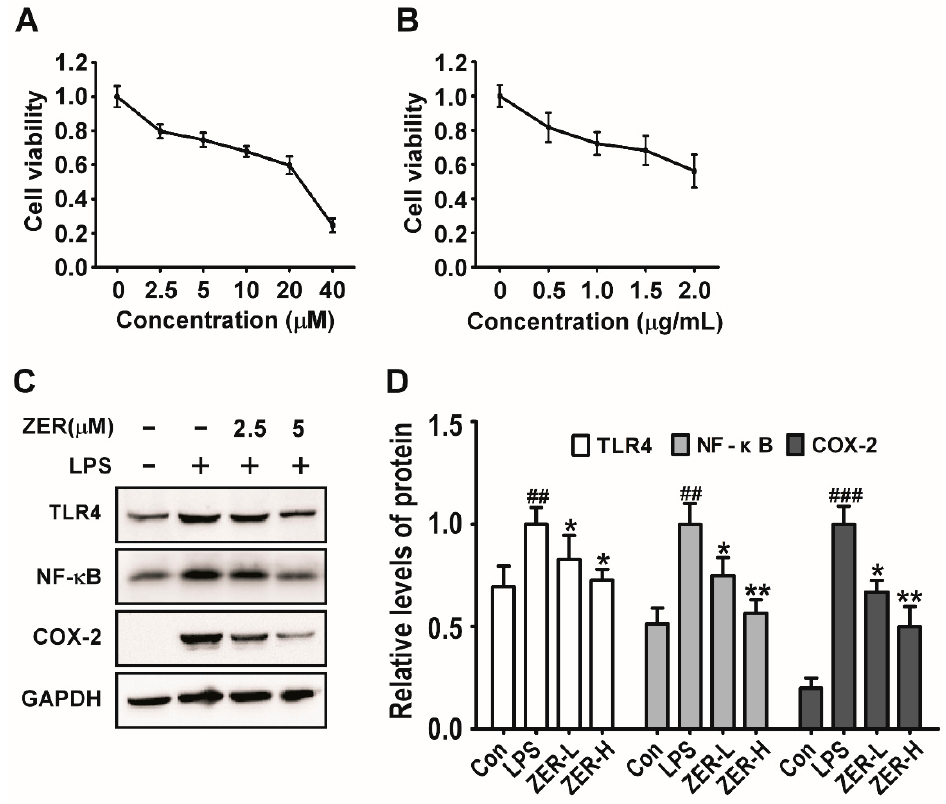
Figure 6. Effects of ZER on TLR4/NF- κ B/COX-2 signaling in LPS-induced Raw264.7 cells. ( A ) The cytotoxicity of ZER was evaluated by MTT assay. ( B ) The cytotoxicity of LPS was evaluated by MTT assay. ( C ) Western blotting analysis of TLR4, NF- κ B (p-p65), and COX-2; GAPDH was used as the loading control. ( D ) Quantification of the relative protein levels of TLR4, NF- κ B (p-p65), and COX-2. Values represent the mean ± SD ( n = 3). ## p < 0.01 and ### p < 0.001 compared with the control group; * p < 0.05 and ** p < 0.01 compared with the LPS treated group.